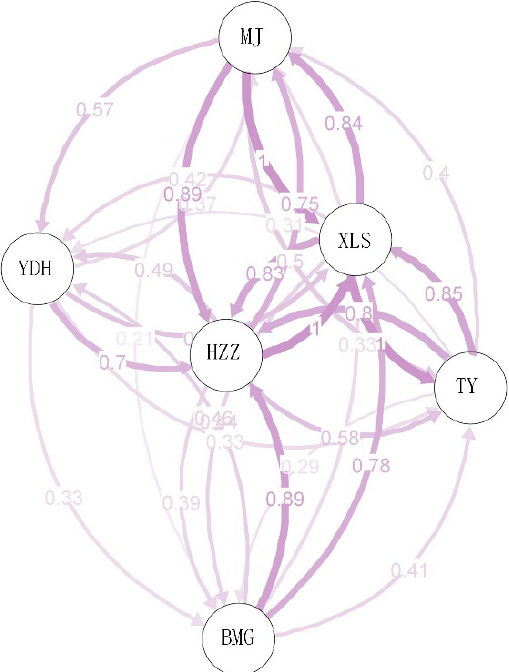
Figure 3. The relative migration networks of six populations from divMigrates. The width of the line and the number shown next to the arrows indicate the migration rate.